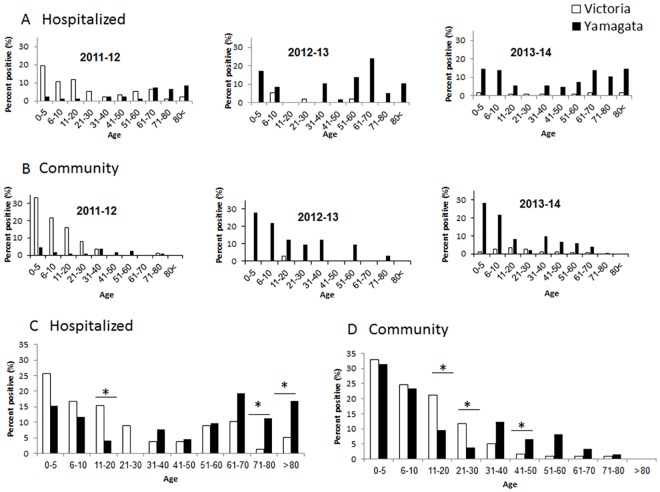
Age distribution of the influenza B-infected patients.The yearly age distribution of hospitalized (A) and community (B) patients positive for infection of influenza B viruses: Victoria and Yamagata between 2011–2014. Summary of the ages over the years in shown in (C-D).